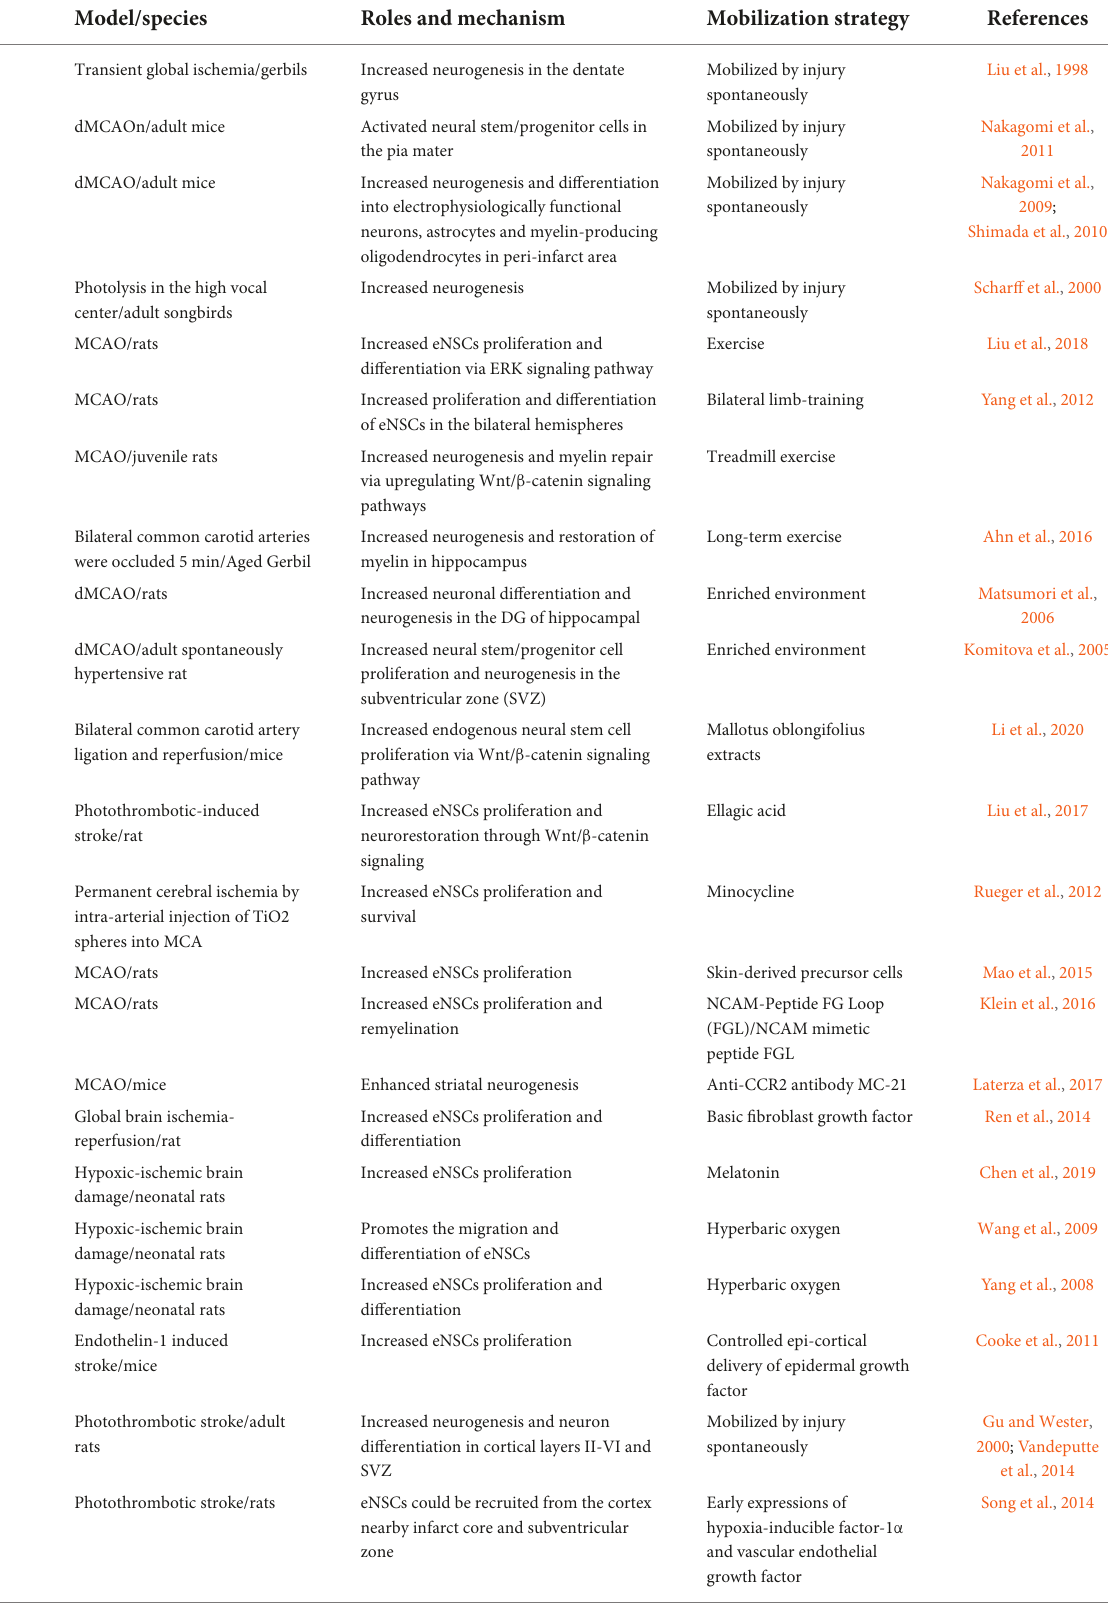
TABLE 1 The roles, mechanism, and mobilization strategy of endogenous neural stem cells in brain